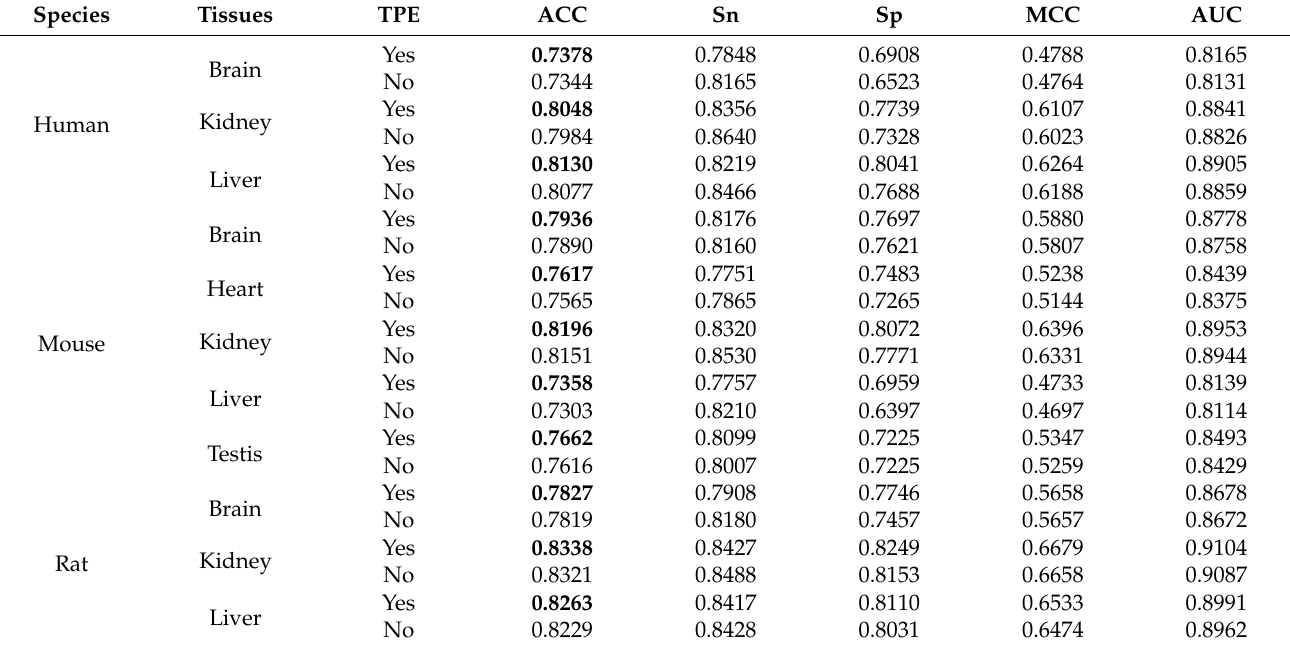
Table 3. The ranges of hyper-parameters that need to be adjusted.